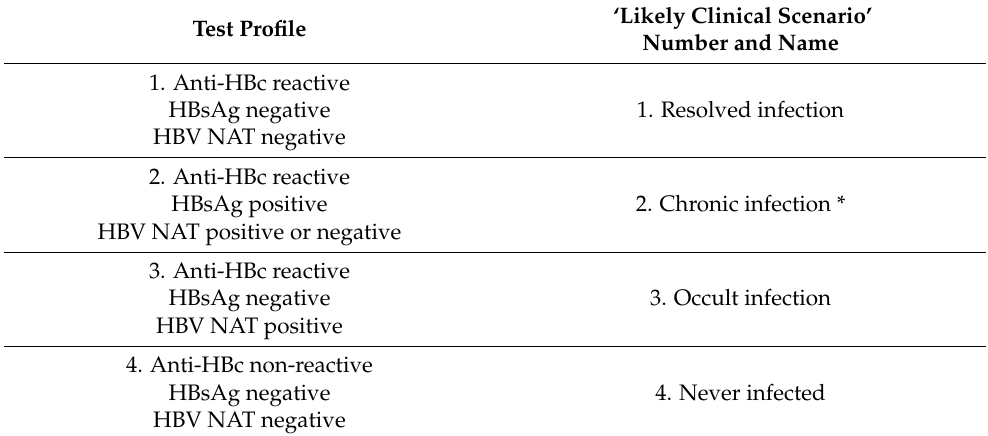
Table 3. Hepatitis B test profiles and likely clinical